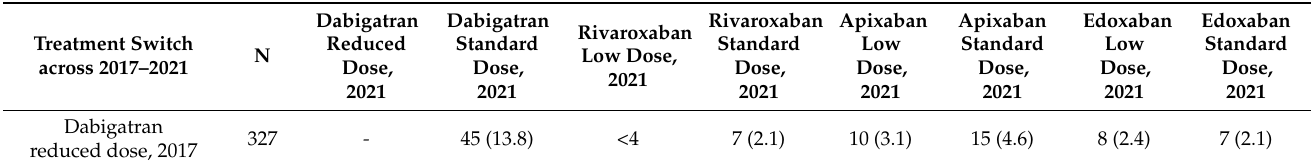
Table 3. Treatment switches between 2017 and 2021 among patients under NOAC (N = 3772), according to